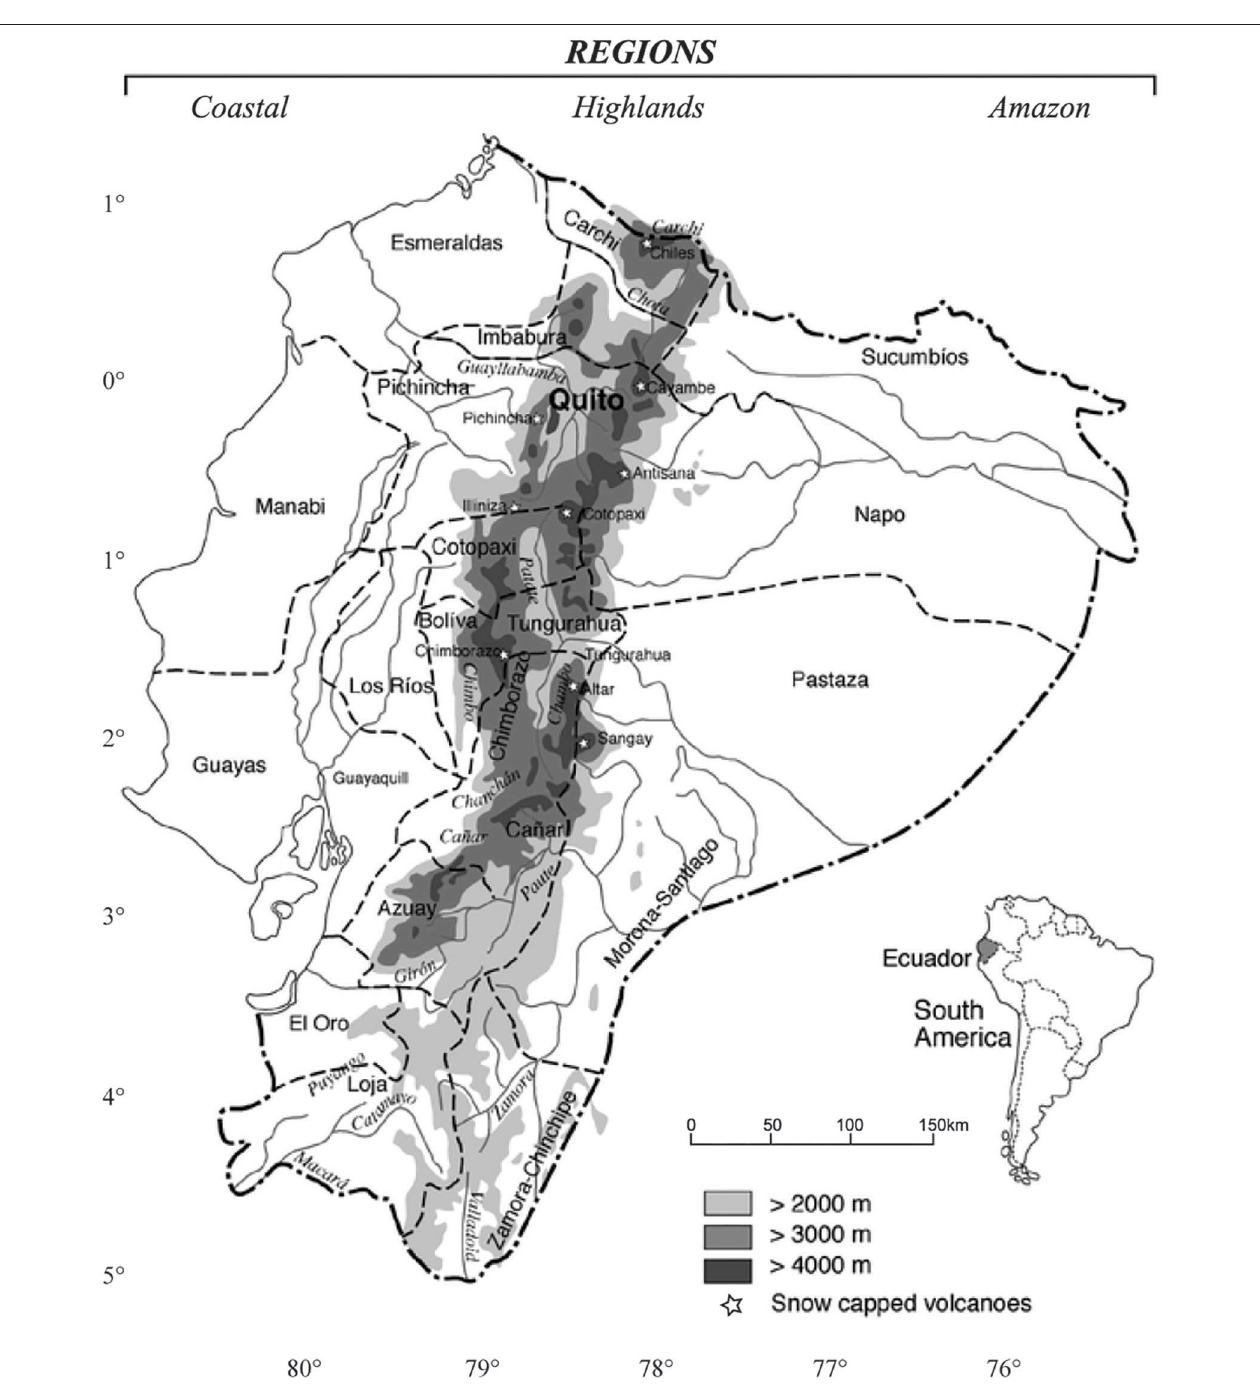
FIGURE 1 | Regions of Ecuador (adapted from Sarmiento and Frolich,